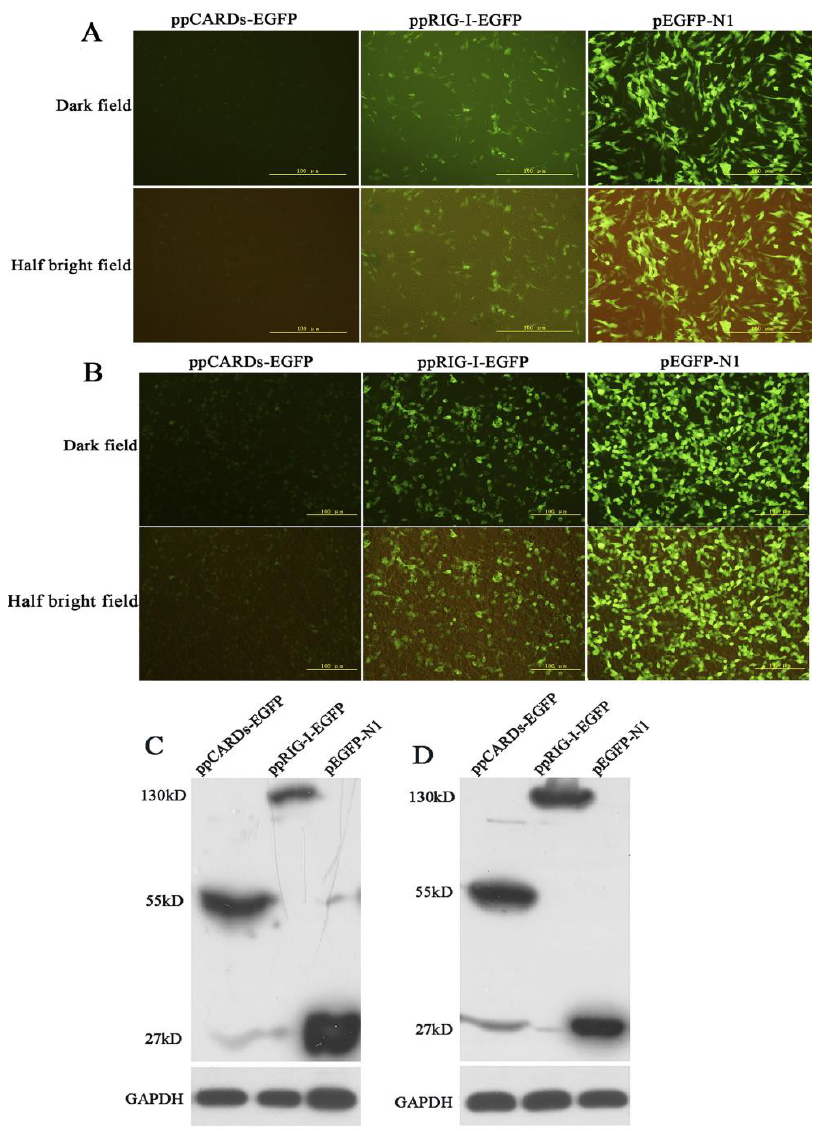
Figure Figure 2. Overexpression of pigeon RIG-I in chicken DF-1 cells and human 293T cells ( A ) DF-1 cells were transfected with pEGFP-N1, ppCARDs-EGFP and ppRIG-I-EGFP. Then, 24 h later, fluorescence microscopy was utilized to examine the EGFP, pCARDs-EGFP and